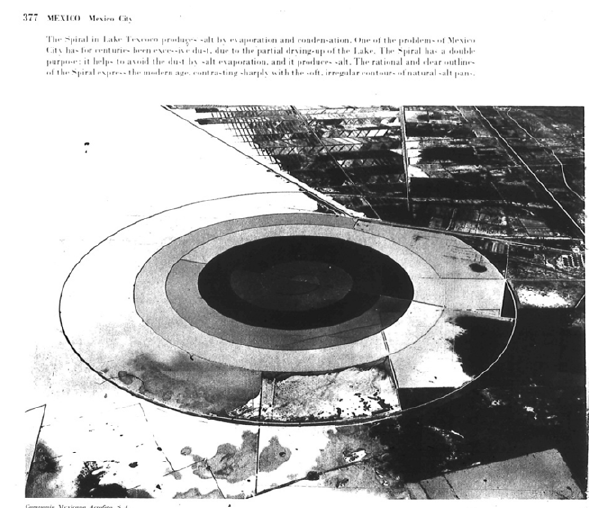
Figure 16. The spiral shape: an aerial view from the Sosa Texcoco company settlings basins in the north of Mexico DF (1944), in the archives of Smithson. RSP Reel 3835, Frame 967